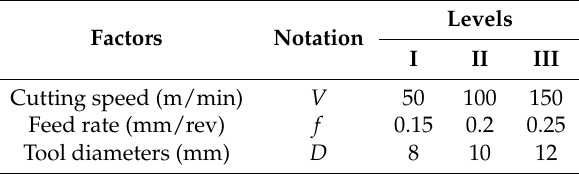
Table 2. Machining factors and their levels.